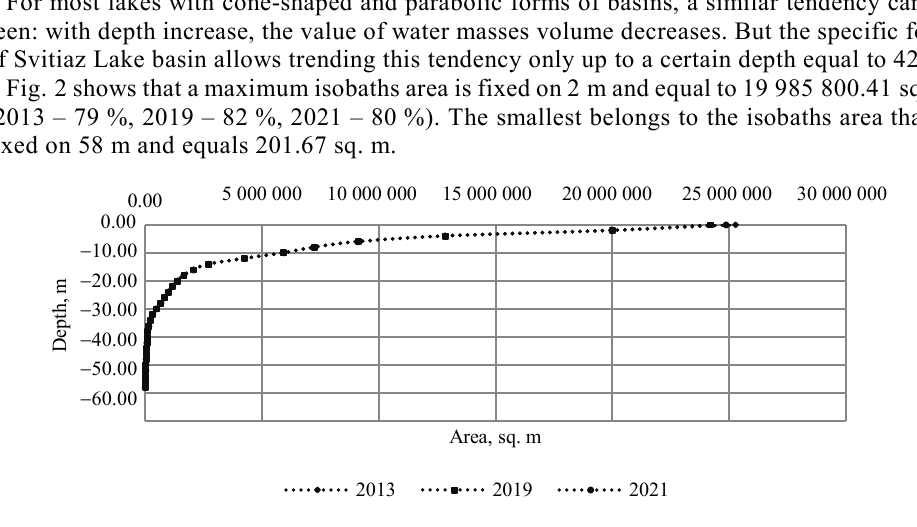
Fig. 2. Bathygraphic curve of Svitiaz Lake (dependence between area and